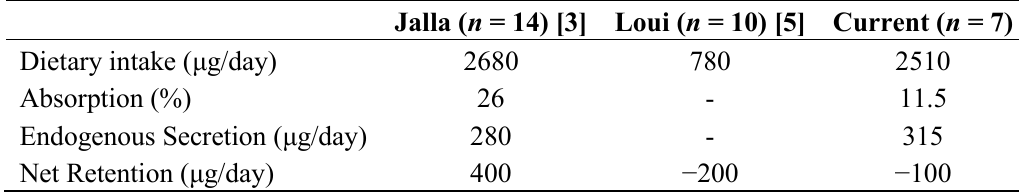
Table 3. Zinc balance data in prior studies compared to current